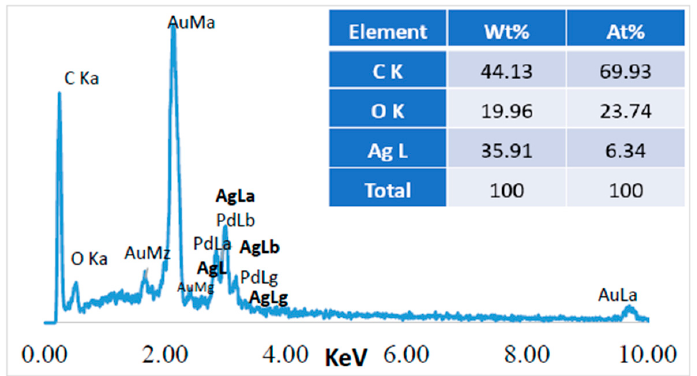
Figure 12. Chemical microanalysis of the jute fabric with Ag NPs obtained with the UV method, using JUV2 sample as example.